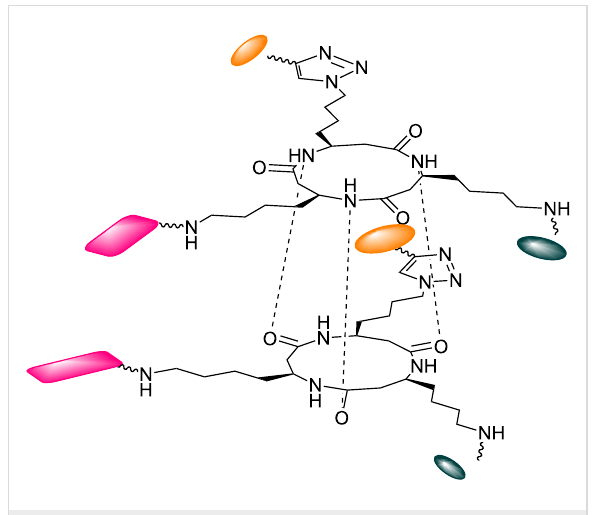
Figure 1: Trifunctional cyclic β -tripeptide forming an intermolecular stack of rings by backbone hydrogen